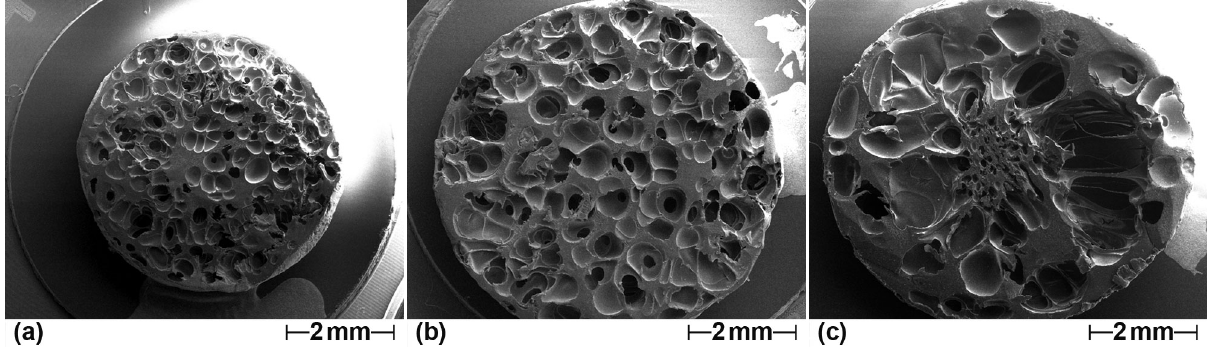
Figure 13. Influence of plasticizer content on foam morphology of CA (1% Unicell